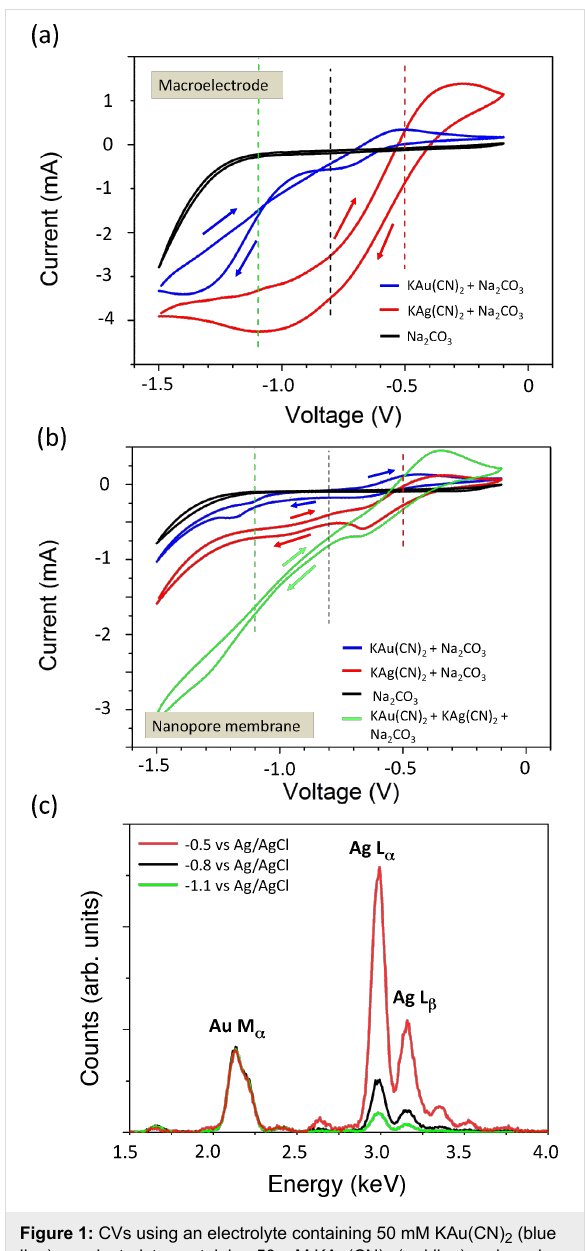
Figure 1: CVs using an electrolyte containing 50 mM KAu(CN) 2 (blue line), an electrolyte containing 50 mM KAg(CN) 2 (red line) and a solu- tion containing only 0.25 M Na 2 CO 3 (black line) using as working elec- trode (a) a gold wire and (b) a nanopore membrane with 10 9 pores/cm 2 and sputtered Au on the bottom membrane side. The green curve in Figure 1b corresponds to a solution containing 50 mM KAuCN 2 and 20 mM KAgCN 2 . (c) Three representative EDX spectra of bundles of nanowires corresponding to different arrays deposited at − 0.5 V (red line), − 0.8V (black line), and − 1.1 V (green line). The spectra are normalized to the energy of the Au M α